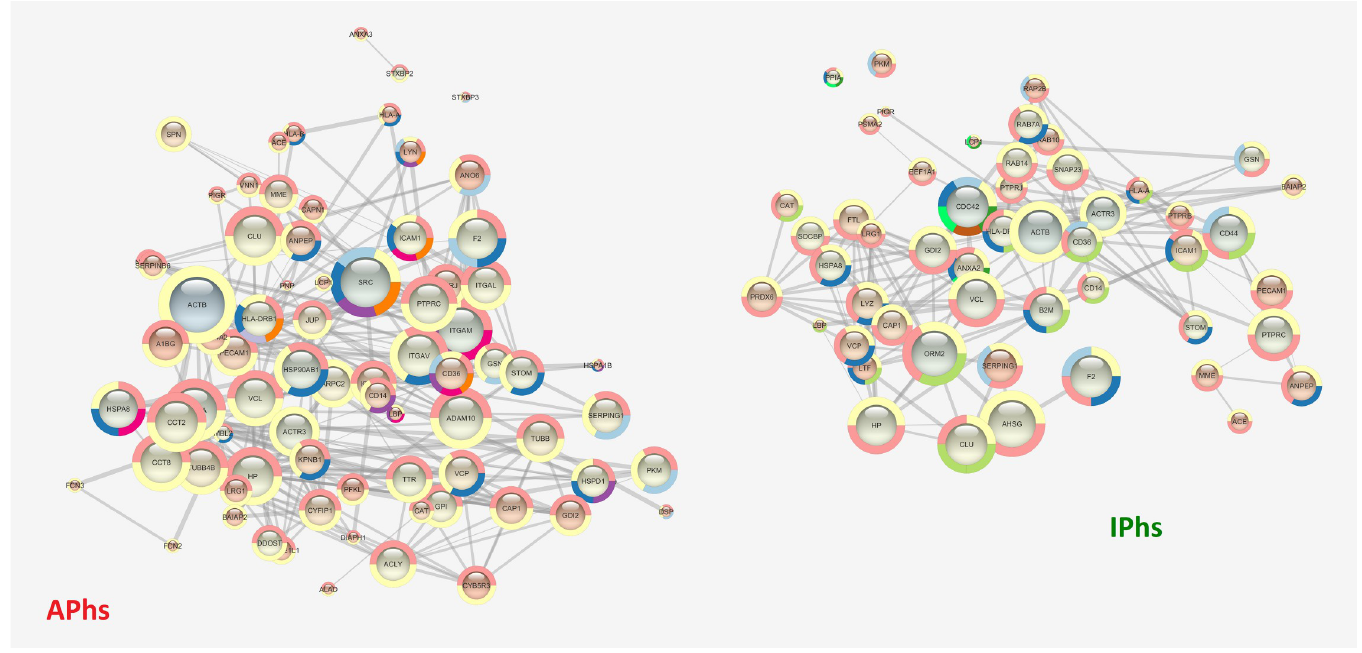
Fig 8. Immune effector networks. The STRING networks corresponding to the GO Term “Immune effector” for APhs (81 proteins; FDR = 9.45E-35) and IPhs (55 proteins; FDR = 7.62E-24) are shown. Besides the different number of proteins involved in the two networks, the term results highly enriched in both datasets but the signalling is based on different proteins: Src, Lyn and certain Integrins (ITGAV, ITGAM, ITGAL) in APhs vs Cdc-42, several Rab proteins and Annexin 2 in IPhs.